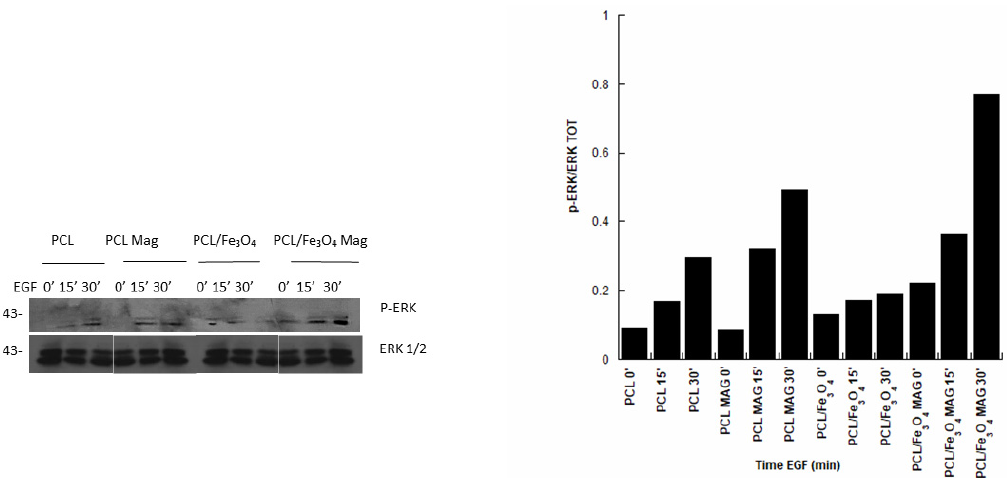
Figure 7. Effect of magnetic field on extracellular signal-regulated kinase (ERK)1/2 phosphorylation. Western blotting analyses were performed on substrates stimulated with a time-dependent magnetic field or left unstimulated. The experimental groups were treated with epidermal growth factor (EGF) at indicated time points (15 and 30 min). Cell-laden substrates were then lysed and subjected to immunoblot analysis with the indicated antibodies. PCL 0’, PCL/Fe ₃ O ₄ 0’, PCL Mag 0’, and PCL/Fe ₃ O ₄ Mag 0’ indicate cell constructs in the absence of EGF.